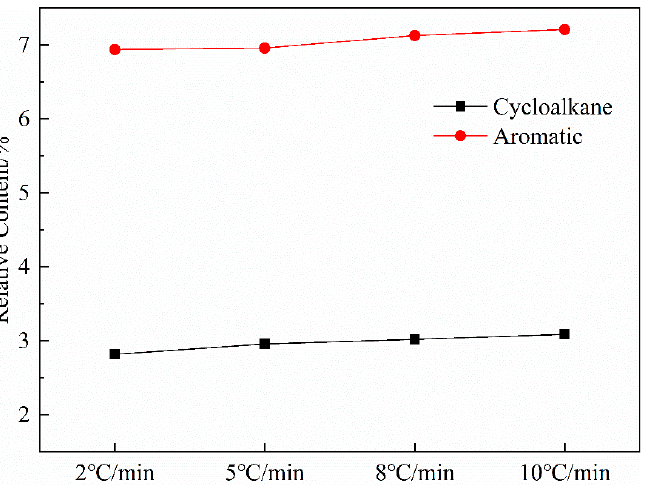
Figure 9. Curves of aromatic hydrocarbon and naphthenic hydrocarbon content in shale oil with heating rate.